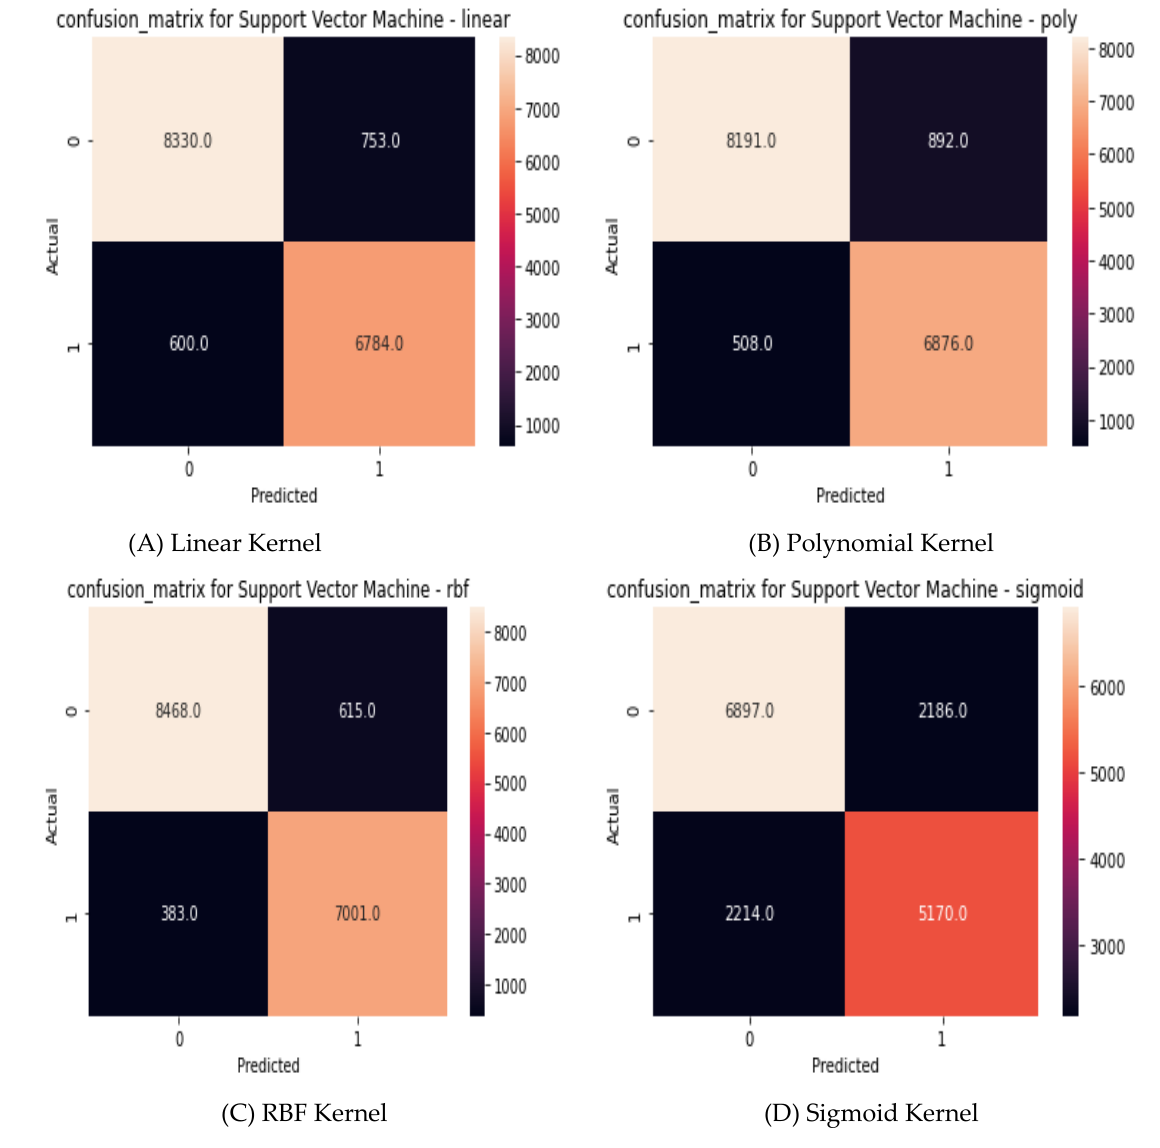
Figure 6. Obtained confusion matrix of UNSW-NB15.